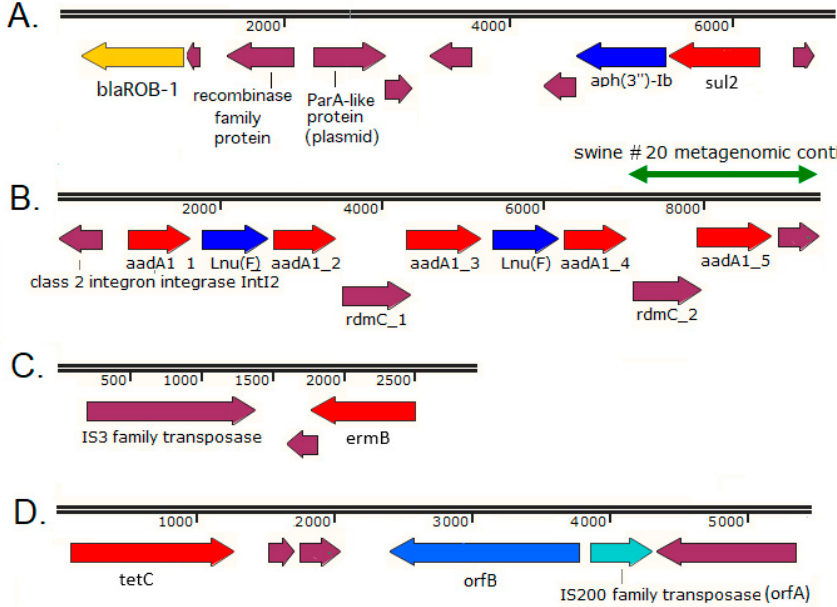
Figure 3. The immediate genetic environment of the acquired ARGs on selected swine gut metage- nomics contigs. Metagenomic contigs from the ileum of swine #12 ( A ), the feces of swine #20 ( B ), the jejunum of swine #2 ( C ), and the jejunum of swine #18 ( D ). The green arrow indicates the 1704 bp region of the E. coli plasmid p702_18_1 that is covered by the swine #20 metagenomic contig ( B ). An erythromycin resistance determinant erm (B) gene, encoding a ribosomal RNA